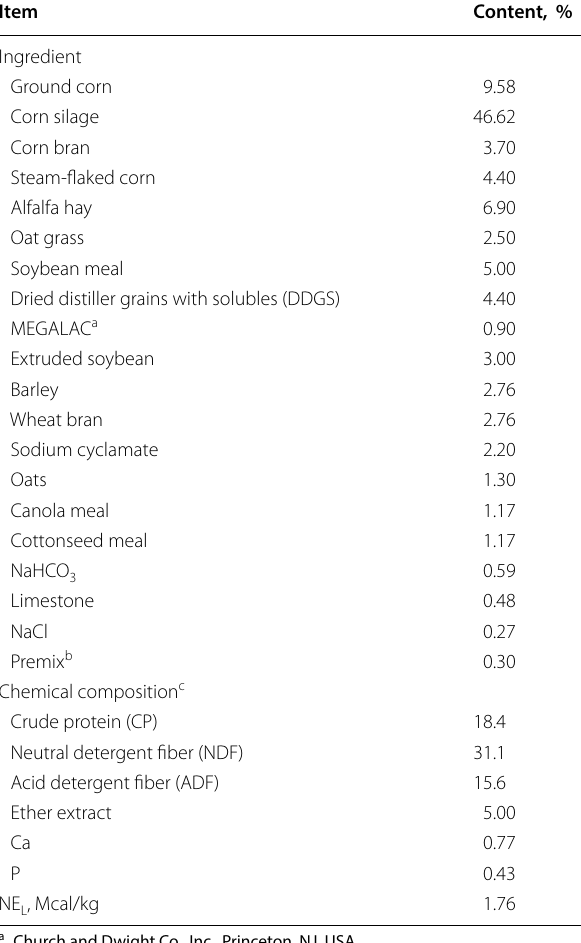
Table 1 Composition and nutrient levels of the basal